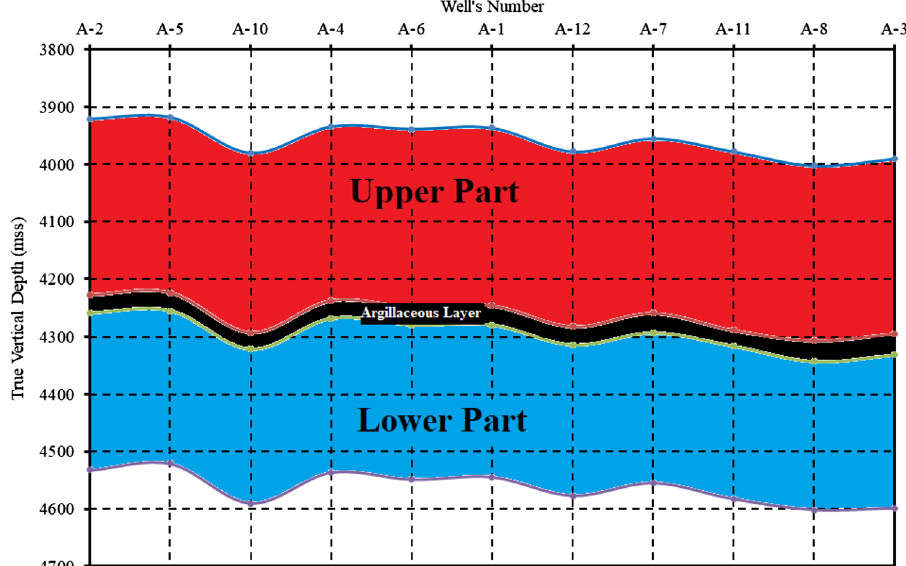
Fig. 8 Wells top formation of reservoir